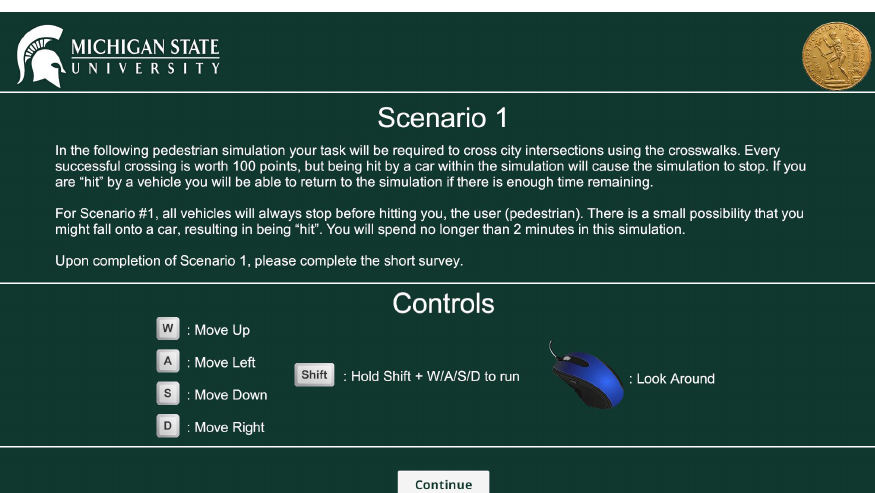
Figure 9. The urban area of the three scenarios features various buildings, vehicles, a skybox, and a weather system.